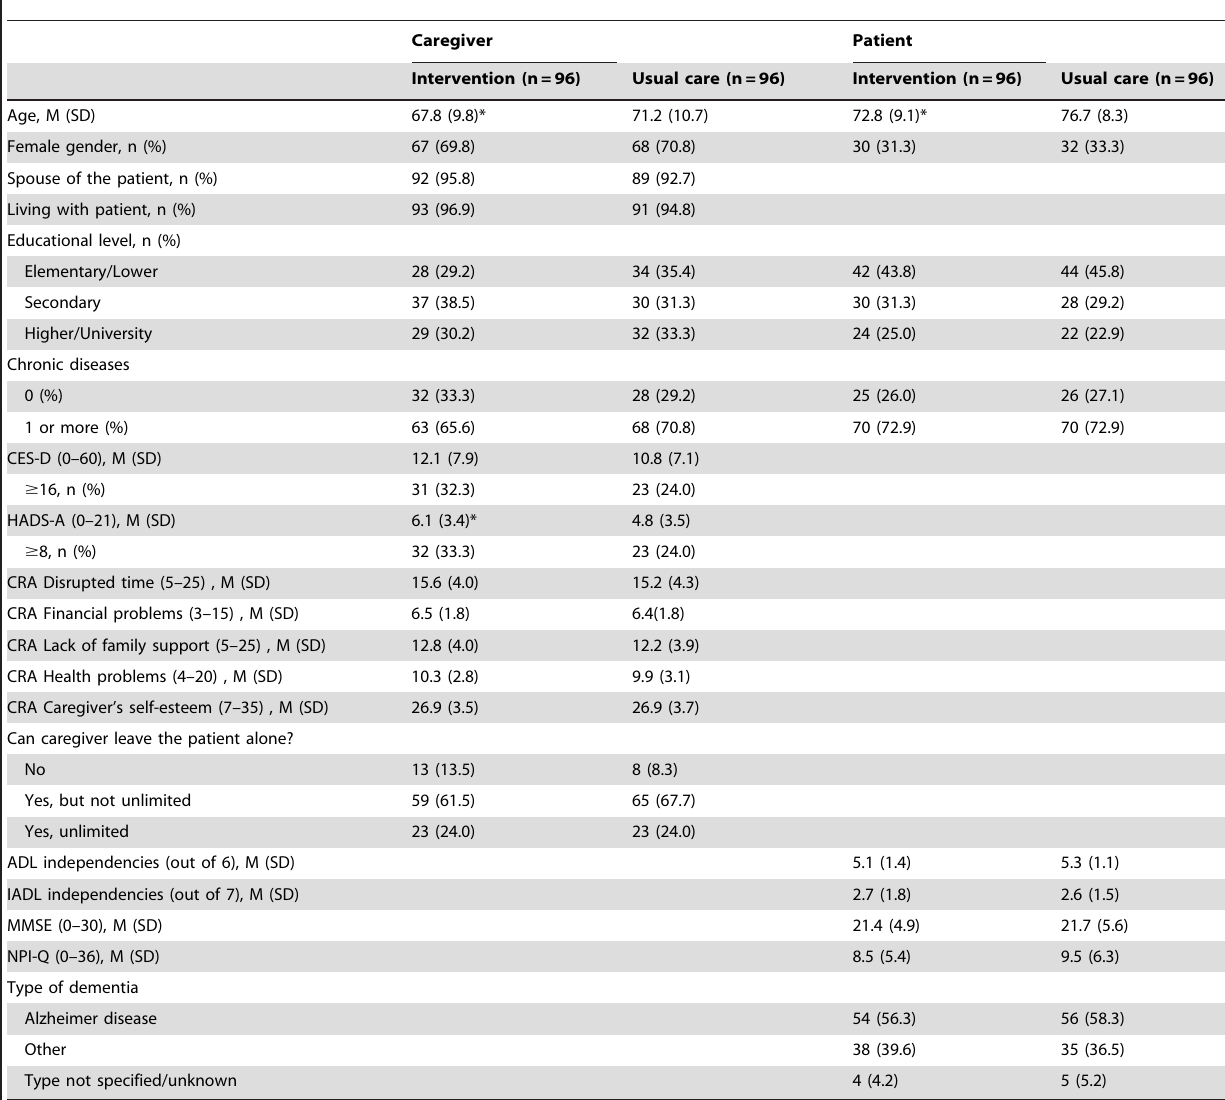
Table 1. Baseline demographic and clinical characteristics of the caregivers and